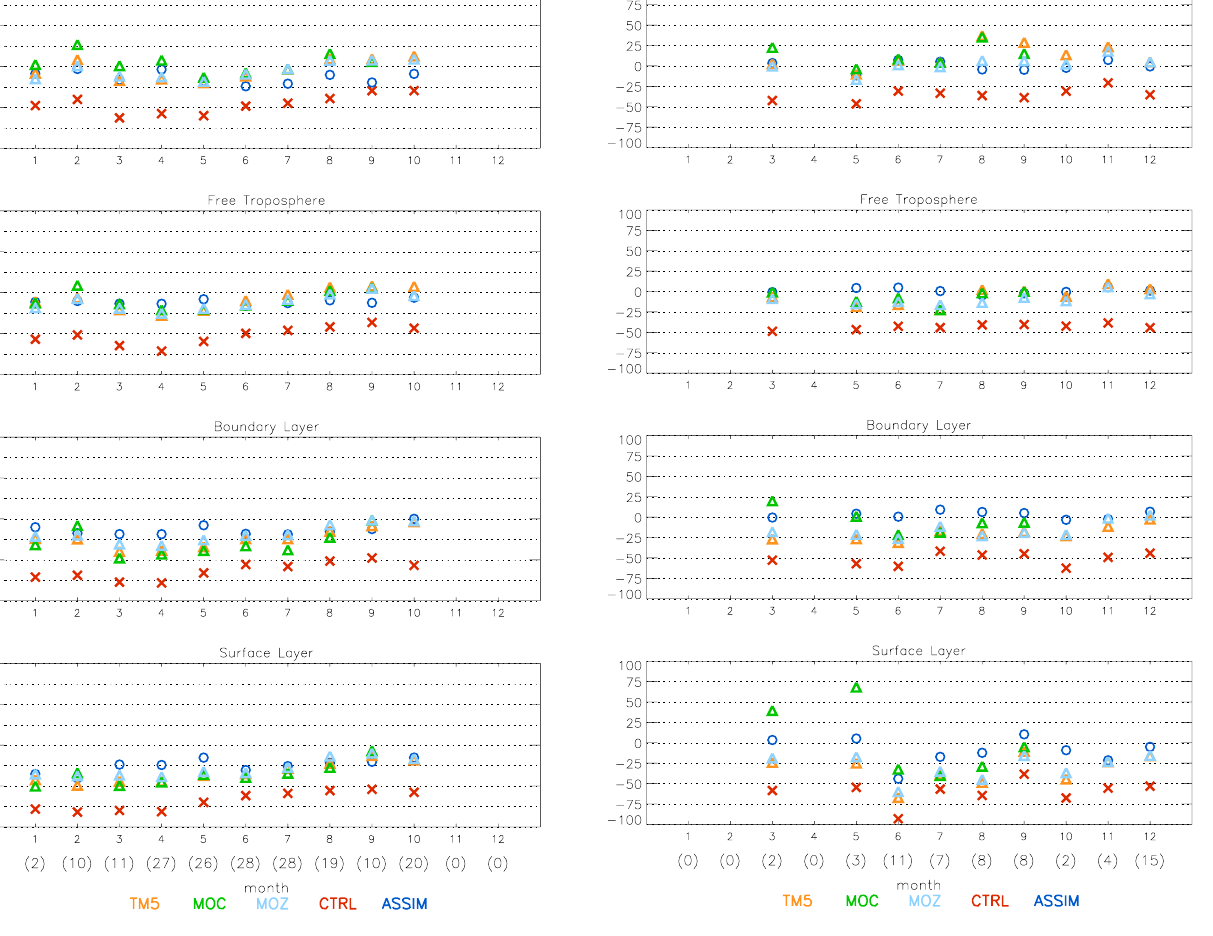
Fig. 8. Same as Fig. 5 except over Atlanta. Fig. 9. Same as Fig. 5 except over Abu